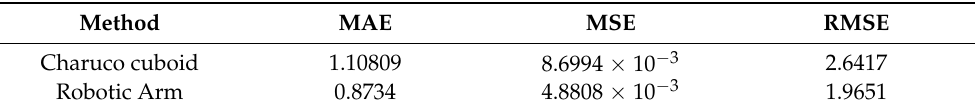
Table 2. Summary results for cuboid and TCP reconstruction with MAE, MSE, and RMSE for unfiltered data.